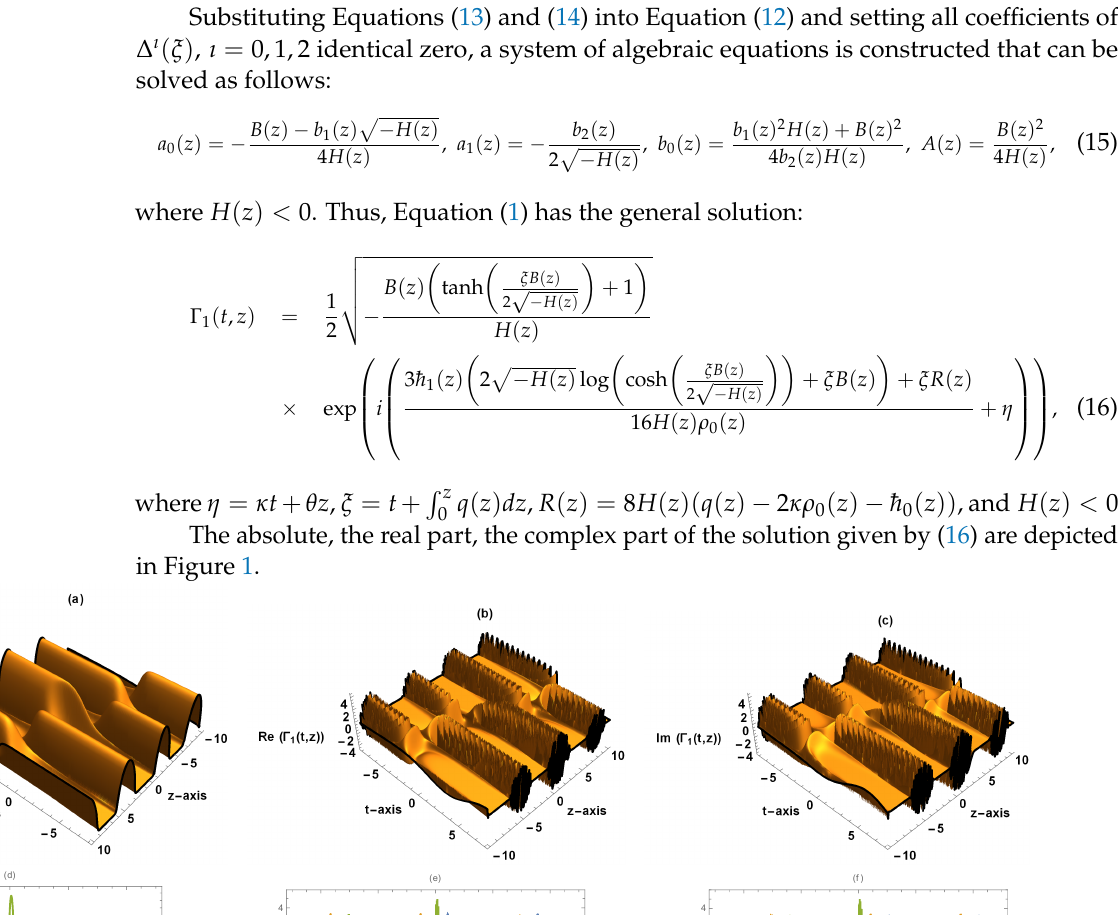
( t , z ) given by (16) in 3D and 2D plots for ρ 1